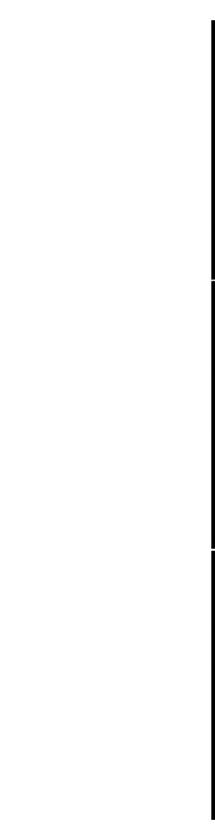
Figure 6. Unclassified cardiomyopathy. Isolated left ventricular non-compaction in a 45 year-old male, with mild systolic dysfunction (EF 48%), ventricular arrhythmias and normal LV diameters. Multiple trabeculations and recesses are evident,particularly in the apex and thefree wall of the LV(panels A and C: apical4 chambers view; panels B and D: apical 3 chambers view). CMR confirmed the diagnosis (panels E–F). Abbreviations: LV = left ventricle, RV = right ventricle IVS = inter-ventricular